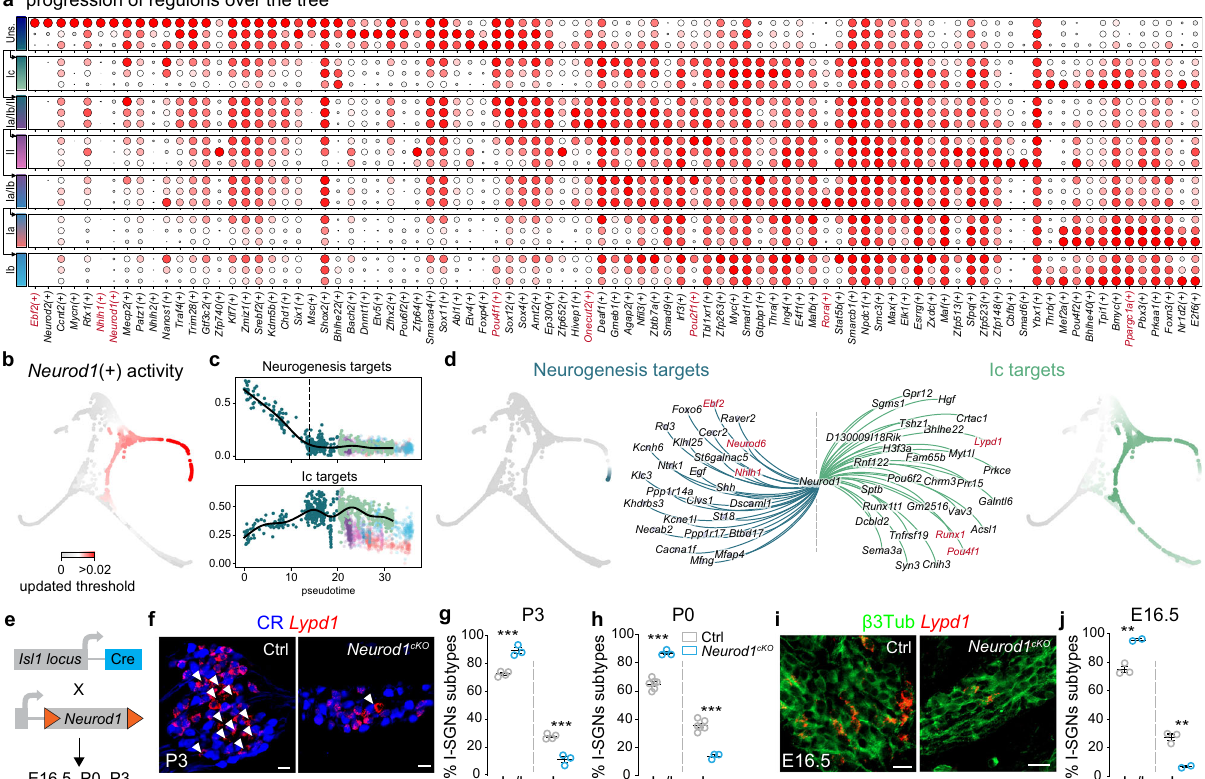
Fig. 3 Gene regulatory network analysis identi fi es regulons essential for SGN diversi fi cation. a Dotplot showing the developmental progression of regulons associated with the different cell states and transitions along the diversi fi cation tree shown in Fig. 2a; the color bars on the left indicate cell states as in Fig. 2a. b Plot showing developmental progression of Neurod1 ( + ) after reducing the threshold score. c Plots showing developmental (pseudotime) progression of two regimes of activity of Neurod1 ( + ) along the differentiation tree. A fi rst regime is active at the beginning of the unspecialized population state, is associated with neurogenesis targets and decreases progressively towards the fi rst bifurcation (representing fate choice between I c and I a /I b /II); a second regime is progressively active in cells as they reach the fi rst bifurcation and continues to be active in the I c trajectory. d Gene regulatory network representation of Neurod1 ( + ) showing its two regimes of activity associated with either neurogenesis (left) or I c targets (right). e Genetic strategy for conditional deletion of Neurod1 from postmitotic SGNs. f – j Neuronal diversi fi cation phenotype in cochlea of Neurod1 cKO mice at E16.5, P0 and P3. At P3 ( f , g ) and P0 ( h ), I a -, I b - and I c -SGNs are CR + , CR + / Lypd1 + and Lypd1 + /CR - (arrowheads in f ), respectively. At E16.5 ( i , j ), SGNs are immunostained for β III- tubulin and only emerging I c -SGNs express Lypd1 (see Fig. 1). Quanti fi cations of labelling are shown in g , h and j . Data in a represent max normalized fi tted AUC scores. Data in c represent mean of minmax normalized gene expression from I c targets and neurogenesis targets, shown as single cell data points as well as gam fi t (line) over pseudotime trajectory. Data in g , h and j are presented as mean ± SEM; circles represent values from individual animals (1 cochlea per animal analyzed, minimum of 5 sections per cochlea, basal and mid-basal regions; n = 2 – 6 animals per genotype, per stage); t-test, ** p < 0.01, *** p < 0.001. Source data are provided as a Source Data fi le. Genes referenced through the text are highlighted in red in a and d . Scale bars: 20 µ m. Ctrl.